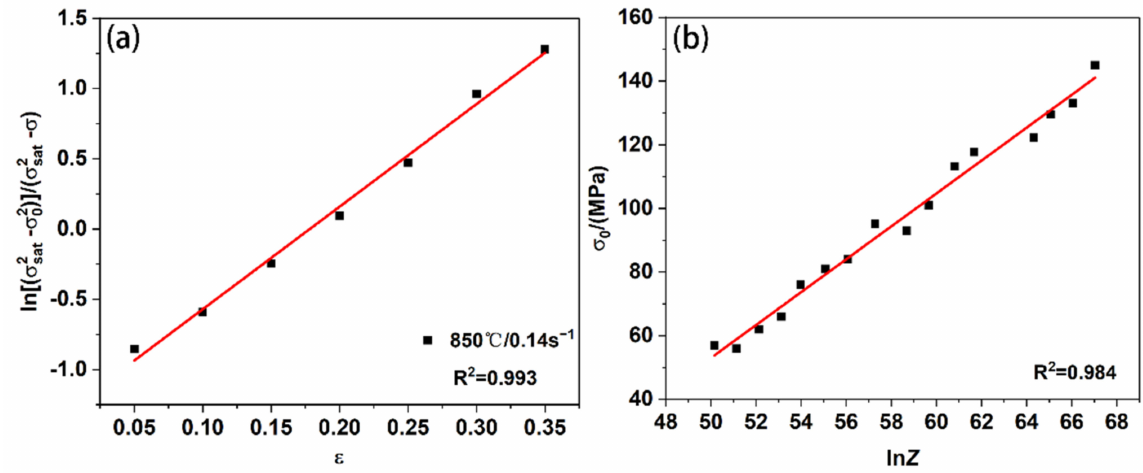
Figure 6. Relationship between: ( a ) ε − ln[( σ 2 sat − σ 2 0 )/( σ 2 sat − σ 2 )], and ( b ) ln Z − σ 0